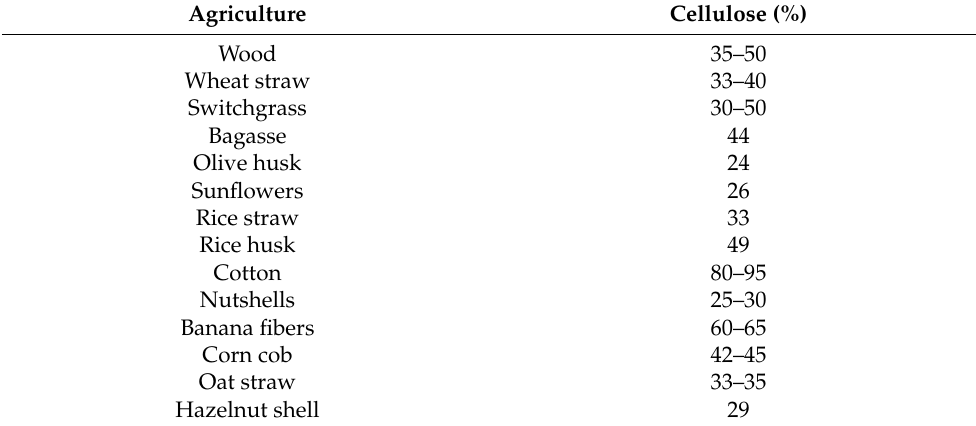
Table 1. Cellulose content within different biomasses from agricultural